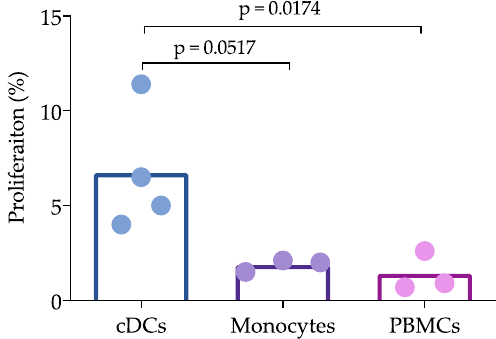
Figure 6. Capacity of cDCs (stimulated with PRRSV) to induce the proliferation of CD3 + cells. PRRSV at an moi of 0.1 was used to stimulate the cDCs, monocytes and peripheral blood mononuclear cells (PBMCs) for 1 h. Subsequently, the cells were cocultured with CD3 + cells (72 h). Data represent the absolute proliferation, which is the proliferation induced by PRRSV minus the proliferation induced by the mock. The bars represent the mean, and each point represents one pig. Data were analyzed with the nonparametric Kruskal-Wallis test, and significant differences are indicated.